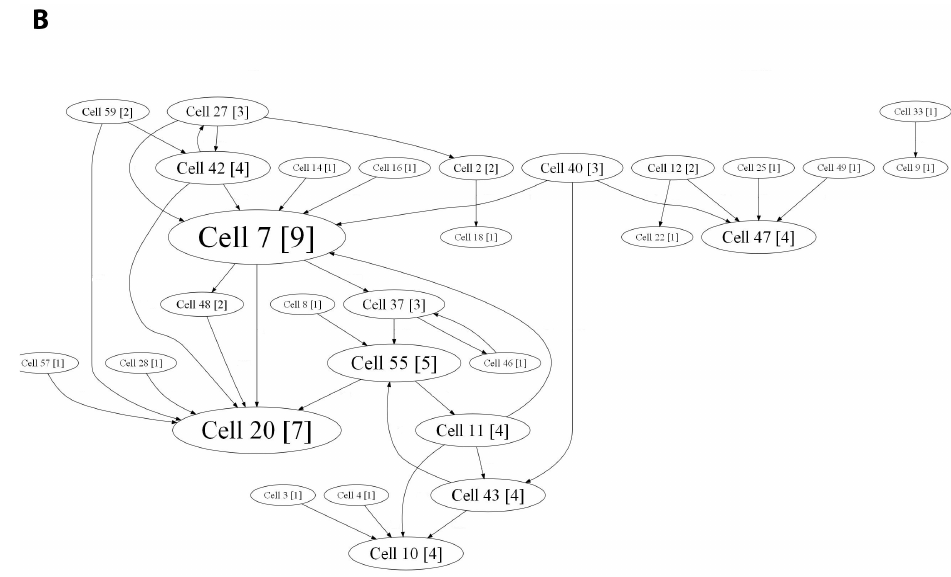
Figure 3. Internal functional structure of neural networks in primary hippocampal cultures after AAV-BDNF-EGFP transduction. Graphical representation of the correlated connections among neurons in the network on 14 DIV. The electrode number is presented as “Cell X”. The number of connections on the electrode is indicated in square brackets. The vertex size is proportional to the number of significant